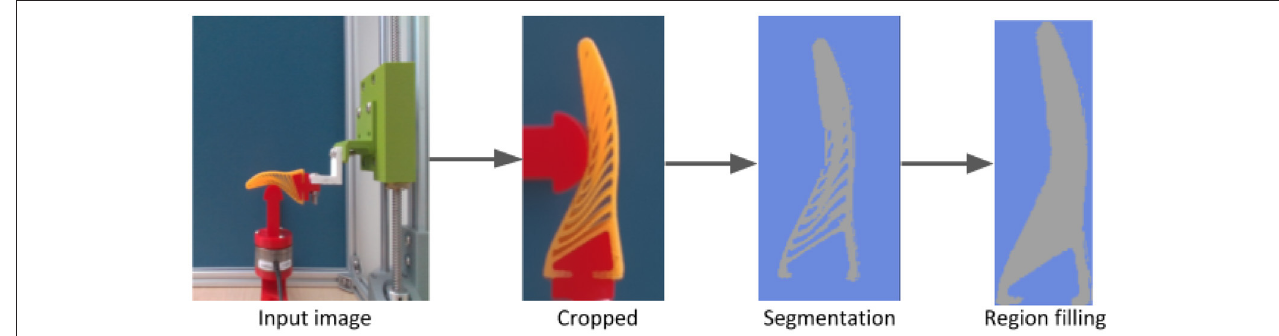
FIGURE 11 | Segmentation Pipeline for real lab experiment. Before feeding the input image to the CNN, we pre-process the image, this image pre-process pipeline consists of cropping followed by a color based segmentation and region filling to fill holes and a final cropping and resizing. This process aims to minimise the domain gap between simulation and real images. However, due to hand-crafted threshold parameters is acceptable to illumination variations. Although we do not focus on bridging this domain gap, we refer the reader to employ recent domain randomisation (Zakharov et al., 2019) and adaptation (James et al., 2019) approaches for optimal results.